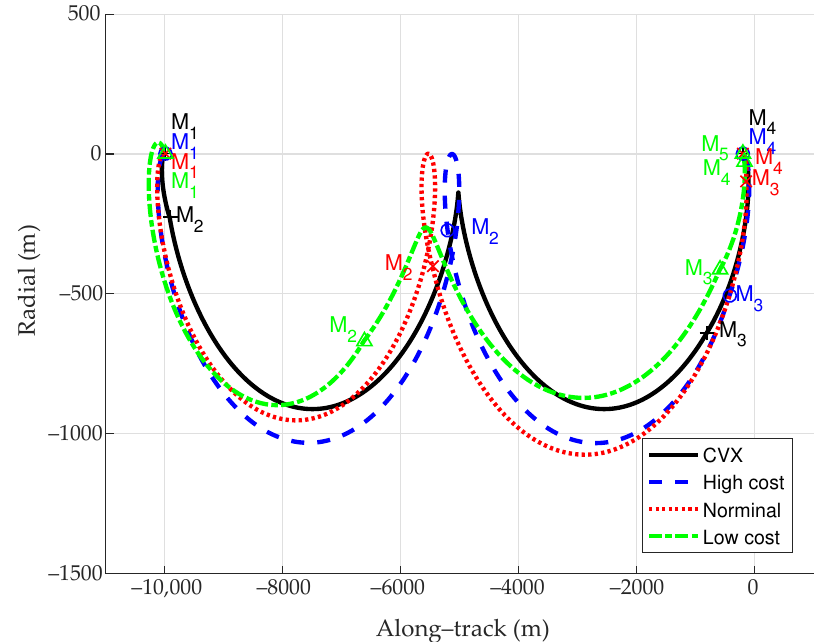
Figure 10. Optimal trajectories(in-plane) when t f = 12,000